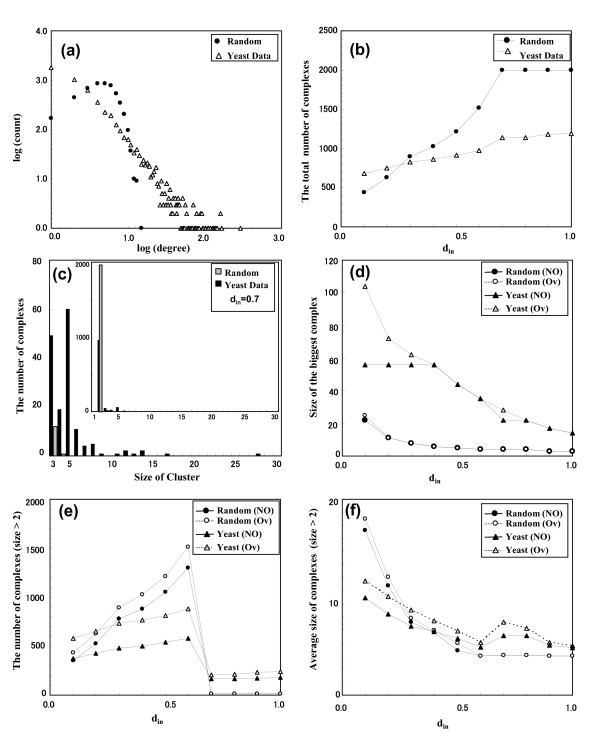
Comparison of yeast PPI network with a random network in the context of (a) degree distribution, (b) total number of complexes, (c) distribution of the complexes generated using din = 0.7 with respect to size, (d) size of the biggest complex, (e) the number of complexes of size ≥ 3 and (f) the average size of the complexes of size ≥ 3. We generated 10 overlapping (Ov) and 10 non-overlapping (NO) sets of complexes by using 10 different values of din for both the networks. We then calculated the aforementioned quantities for each of the generated sets and plotted them.